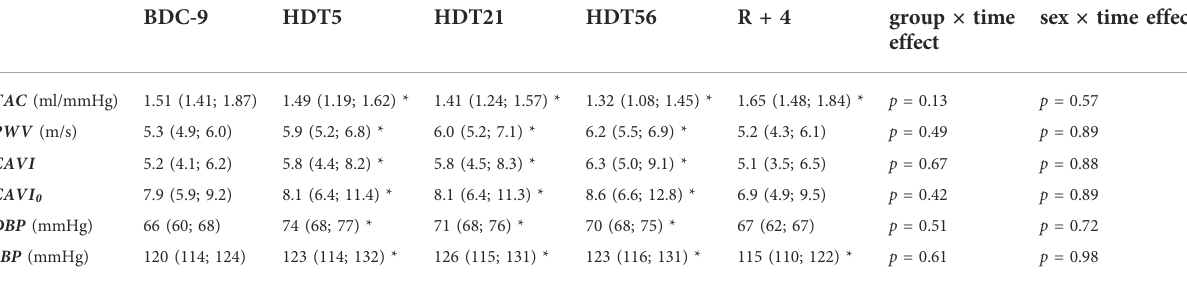
TABLE3Evolutionofbloodpressureandarterialstiffnessresultscomputedbetweenplanes1and4(Figure2)alloverthestudy.Dataarepresentedas median ( fi rst quartile; third quartile). The group × time and sex × time effects are displayed in the last columns. TAC : total arterial compliance, PWV :pulse wave velocity, CAVI :cardio-ankle vascular index, CAVI 0 :updated cardio-ankle vascular index, DBP and SBP :diastolicand systolic blood pressure, respectively, BDC: baseline data collection, HDT: head-down tilt, R: recovery. *: Signi fi cant difference with BDC-9 using the two-stage linear step-up procedure of Benjamini, Krieger, and Yekuteli with a false discovery rate set at